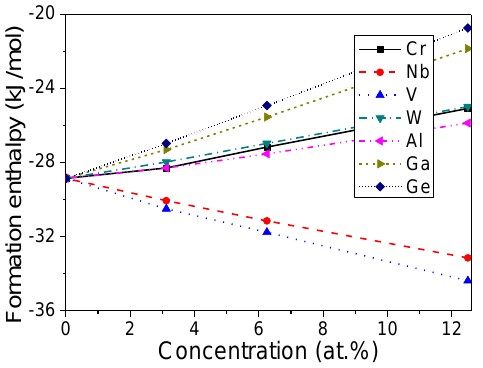
Figure 2. Formation enthalpies of doped Mo 3 Si.